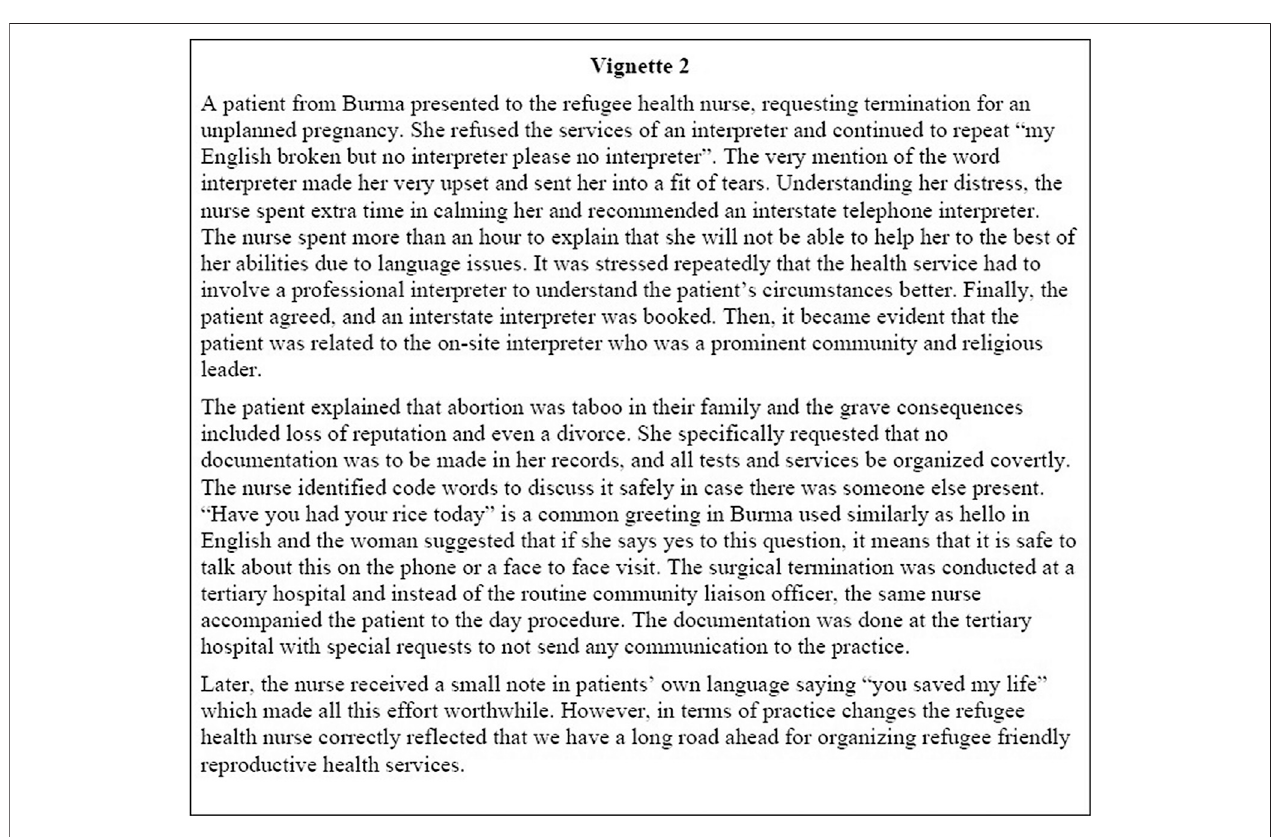
FIGURE 2 | Field notes: The need for safe